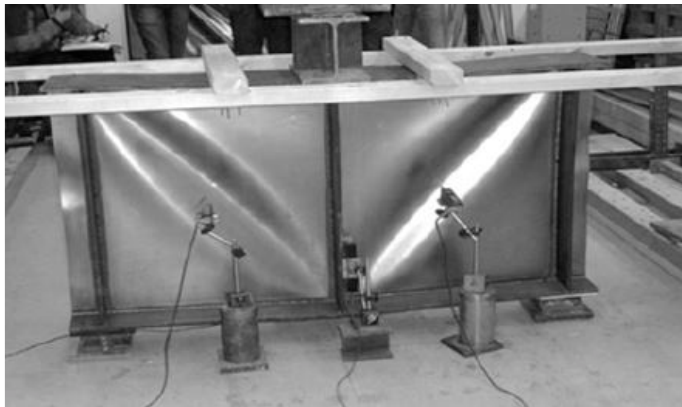
Figure 2. Post-buckling deformation of stiffened plate girder under transverse loading [14] .